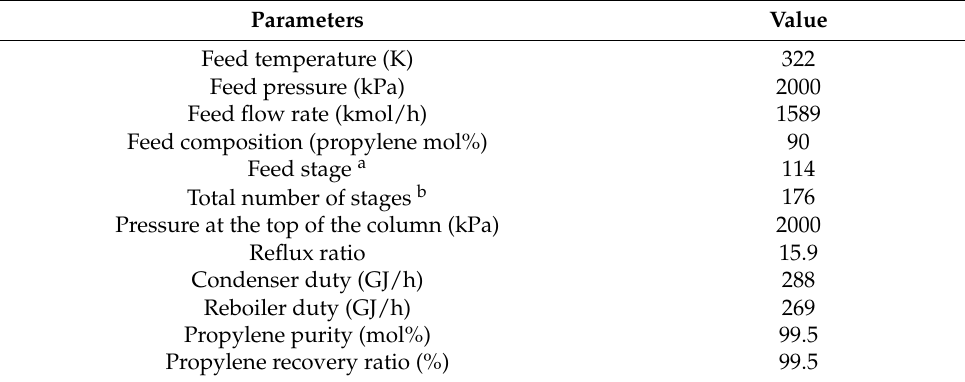
Table 3. Feed, design, and operating conditions of CDiC.